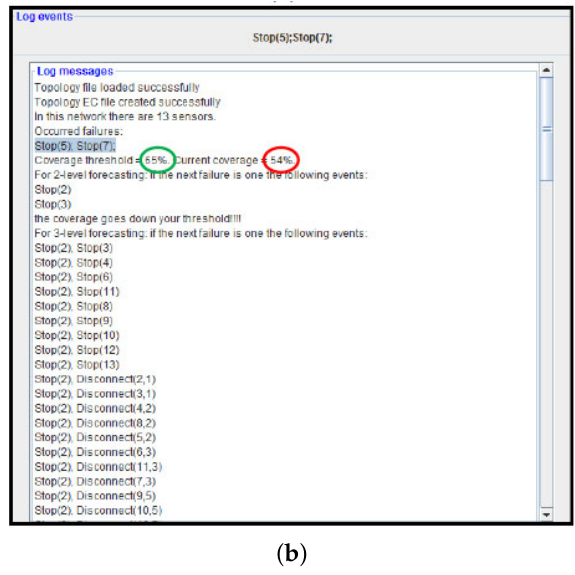
Figure 12. Outcomes of an example of the ADVISES Tool when it is set in Runtime Verification mode. ( a ) Current coverage value is 77% (against the coverage threshold value 65%) in the case of node 5 failure and warnings for next Stop events; ( b ) Current coverage value is 54% (against the coverage threshold value 65%) in the case of both node 5 and 7 failures; in this case coverage is under the threshold value